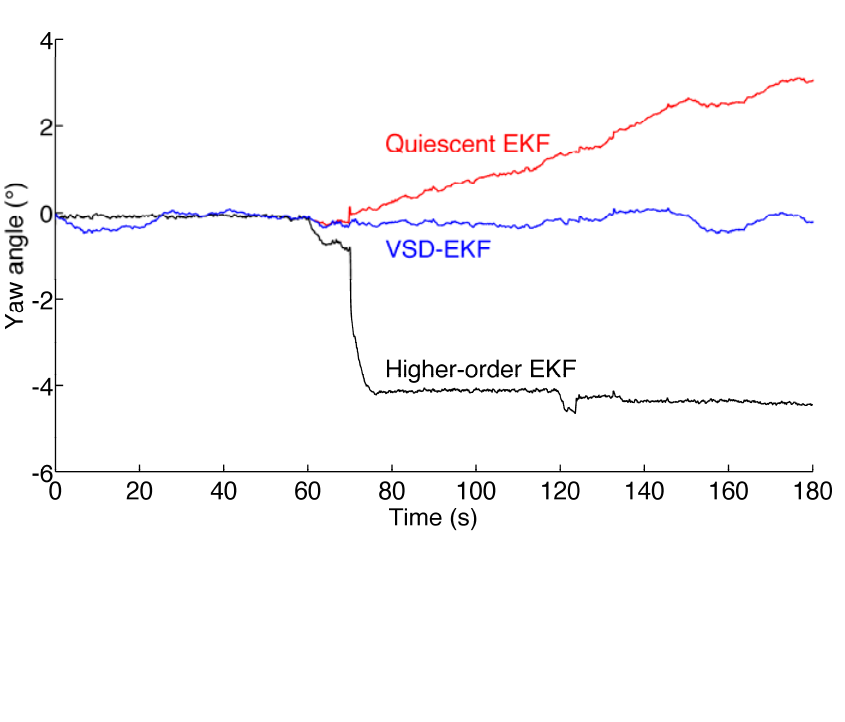
Figure 3. Estimated yaw angle for the three different filters (static